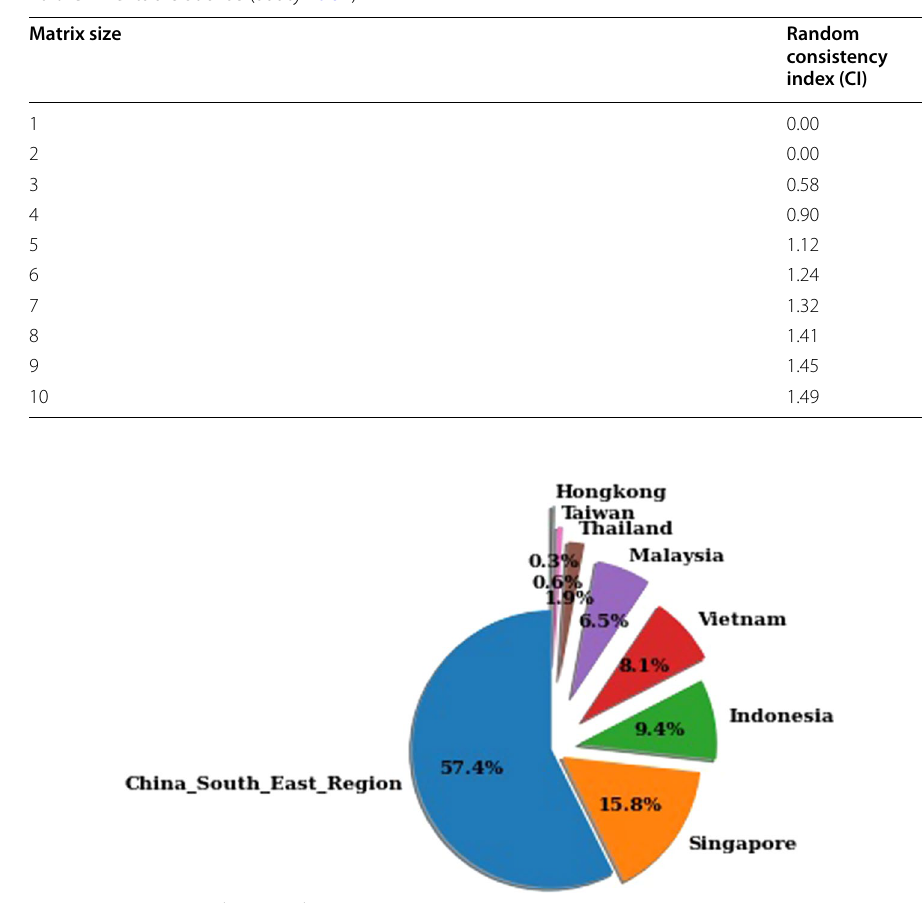
Fig. 1 Maritime casualty in South-East Asia’s